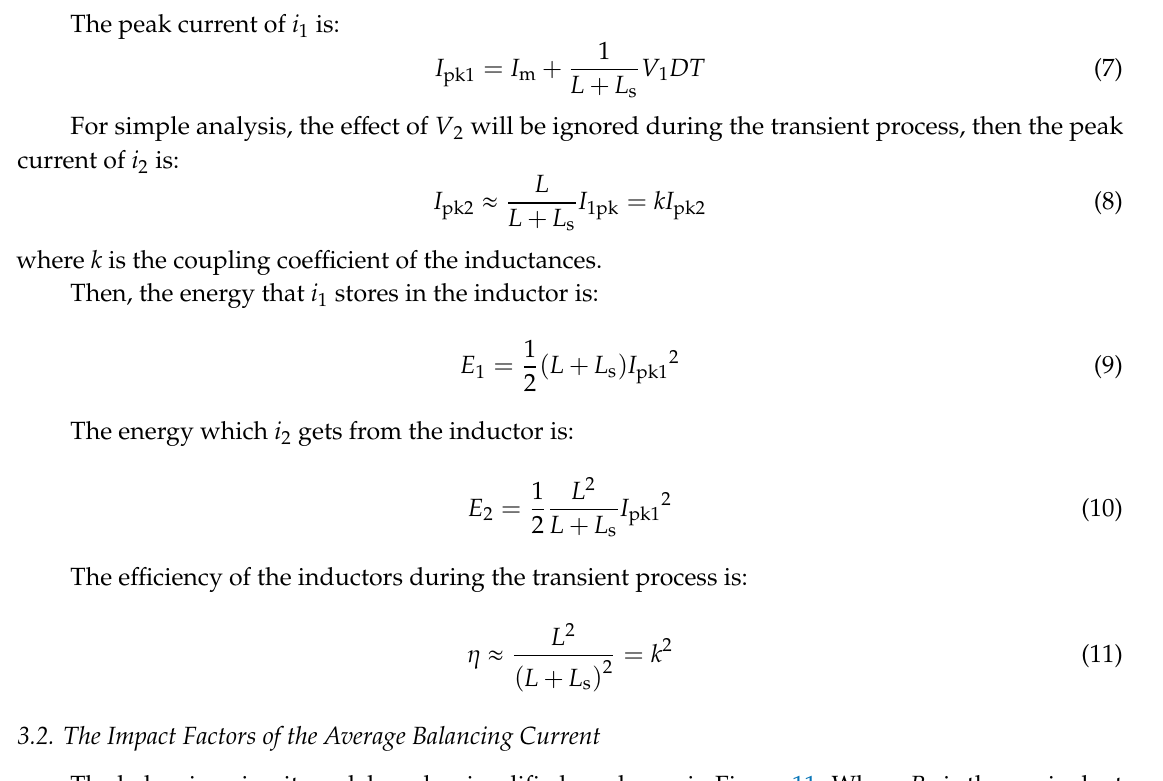
Figure 10. Simplified circuit model with equivalent leakage inductance.